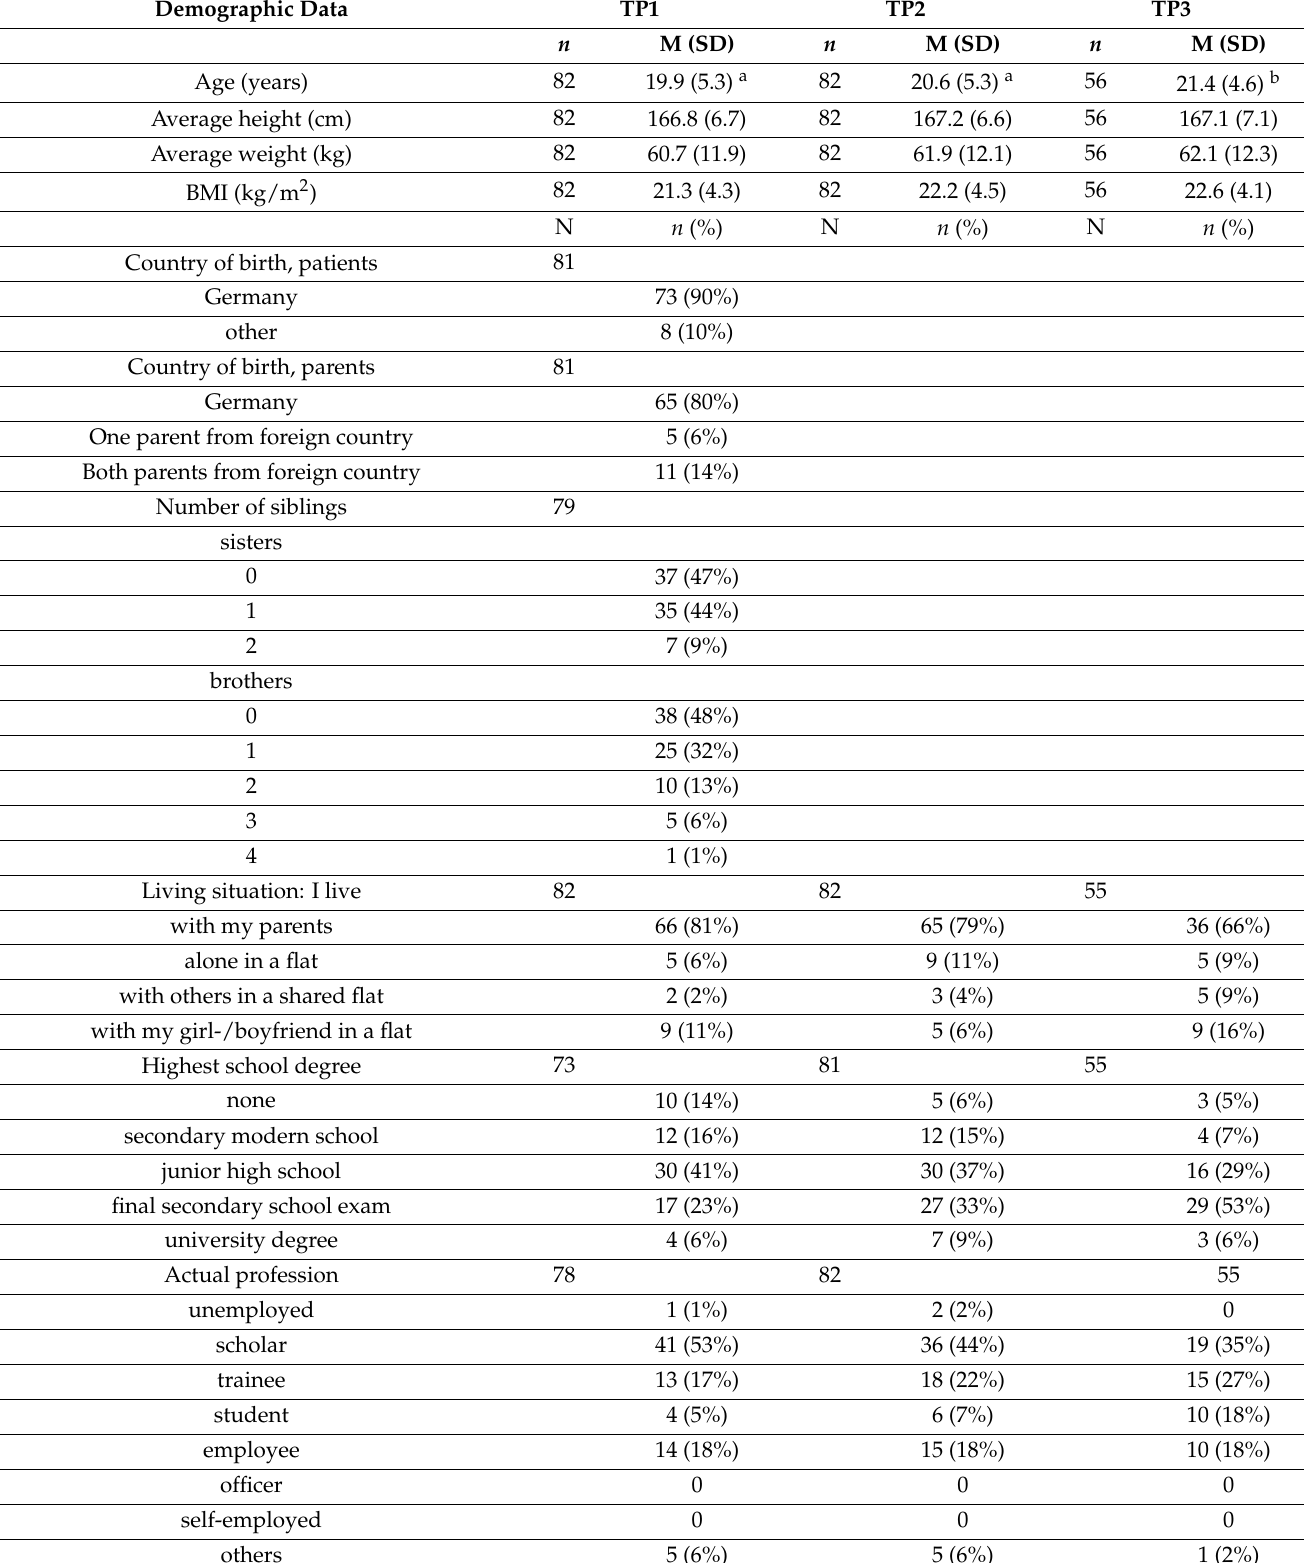
Table 1. Sociodemographic data of MRKHS patients (data collected TP1-3). Demographic